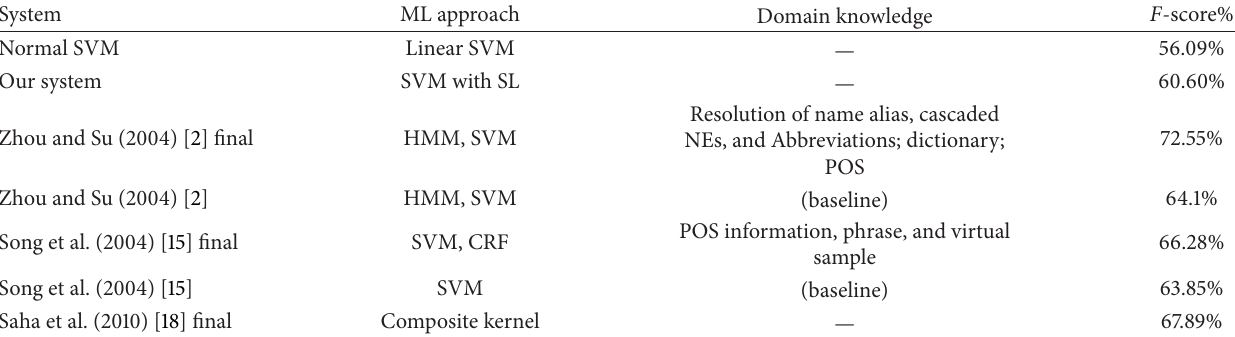
Table 4: Our system compared with existing